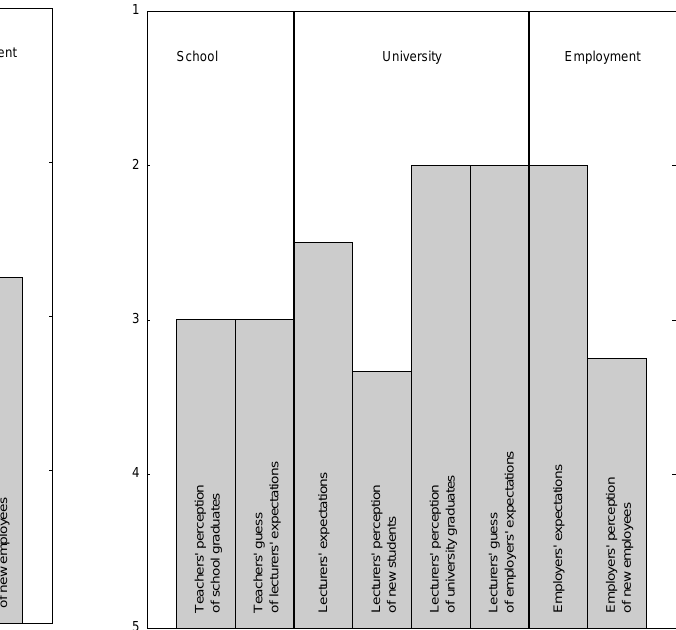
Figure 4. Expectations and perceptions for the competency “Self